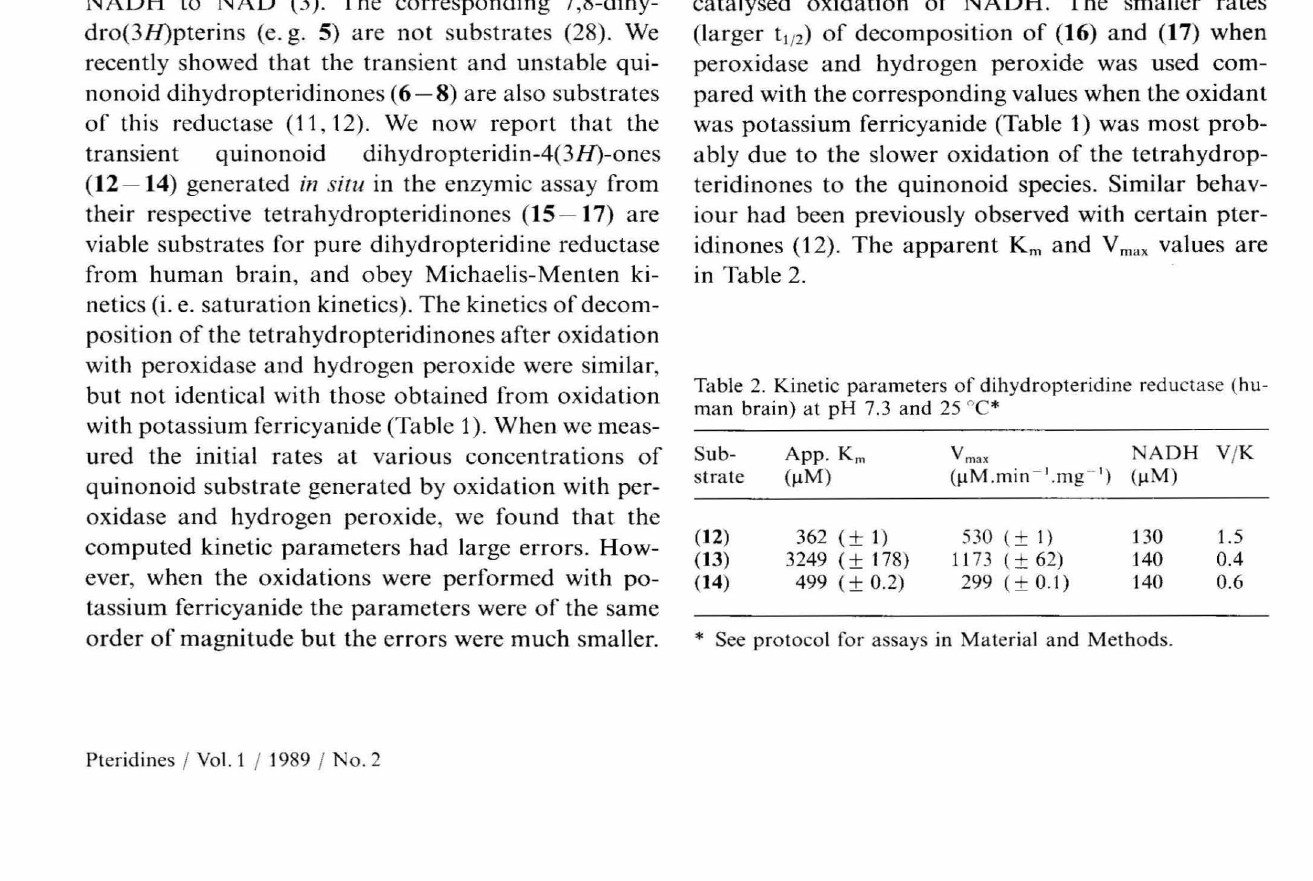
Table 2. Kinetic parameters of dihydropteridine reductase (hu man brain) at pH 7.3 and 25